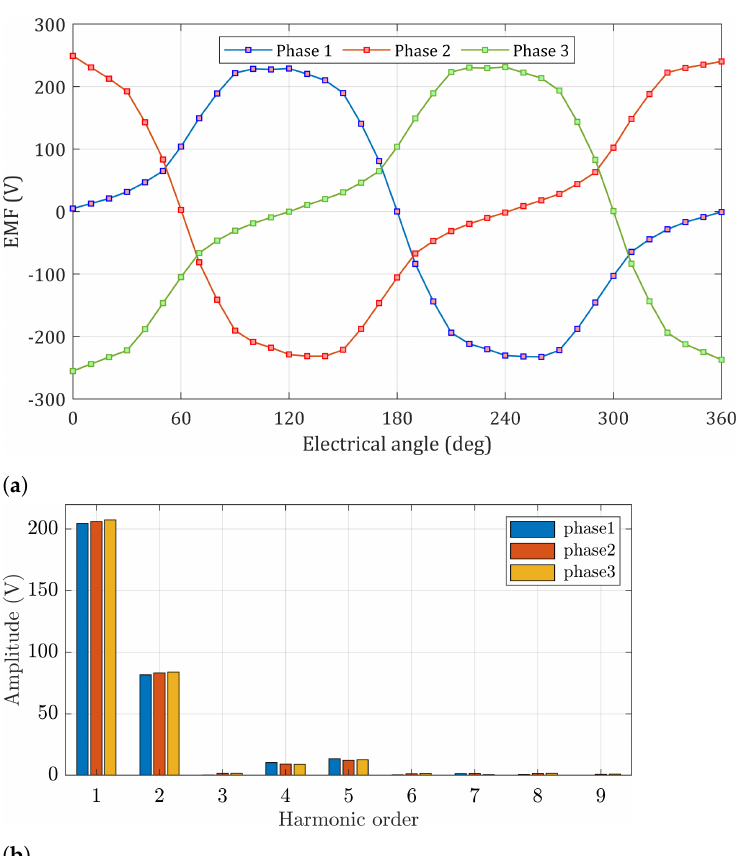
Figure 18. Obtained ORDSPMG electrical analysis: ( a ) EMF vs. electrical angle, ( b ) FFT analysis of